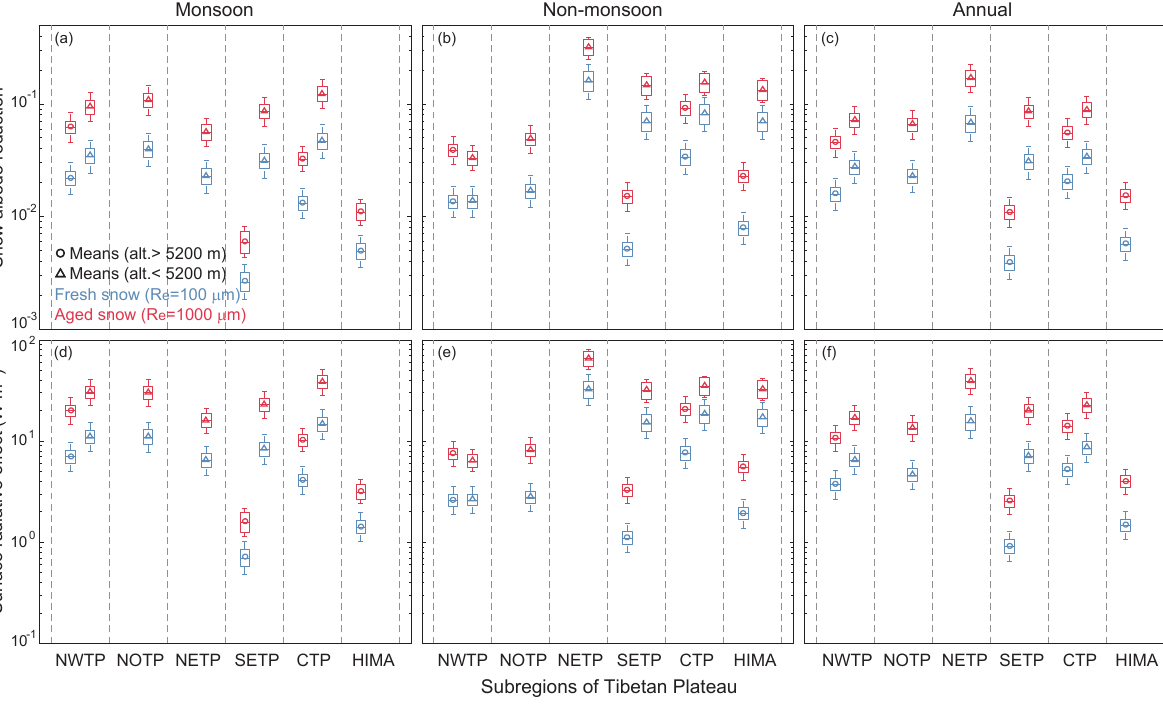
Figure 8. Regional and seasonal mean BC-induced all-sky snow albedo reductions and surface radiative effects during (a, d) monsoon, (b, e) non-monsoon, and (c, f) annual periods in 2000–2015 over six Tibetan Plateau (TP) sub-regions (see Fig. 1), including the northwest- ern TP (NWTP), north of the TP (NOTP), the northeastern TP (NETP), the southeastern TP (SETP), the central TP (CTP), and the Hi- malayas (HIMA). (a–c) Box plots of mean snow albedo reductions within each sub-region based on SNICAR simulations using the observed BC concentrations in snow (Fig. 1), snow thicknesses, and snow densities (see text for details). Results for altitudes >5200 and <5200m are shown as left and right box plots within each sub-region, respectively, with circles and triangles indicating mean values. Model results assume BC externally and internally mixed with spheres, spheroids, hexagonal plates, and Koch snowflakes for fresh (blue, R e = 100µm) and aged (red, R e = 1000µm) snow. Each data point used for the box plot is the sub-regional average assuming a type of snow shape and BC–snow mixing, and hence the box plot indicates the variation caused by effects of snow shape and BC–snow mixing state. Note that some sub-regions only have BC observations at altitudes >5200 or <5200m (see Fig. 1). (d–f) Same as (a–c) , but for BC-induced all-sky surface radiative effects caused by the snow albedo reductions shown in (a–c) . Calculations use the surface downward solar radiation and cloud cover fraction from the MERRA-2 reanalysis fields (see text and Table S2 in the Supplement for